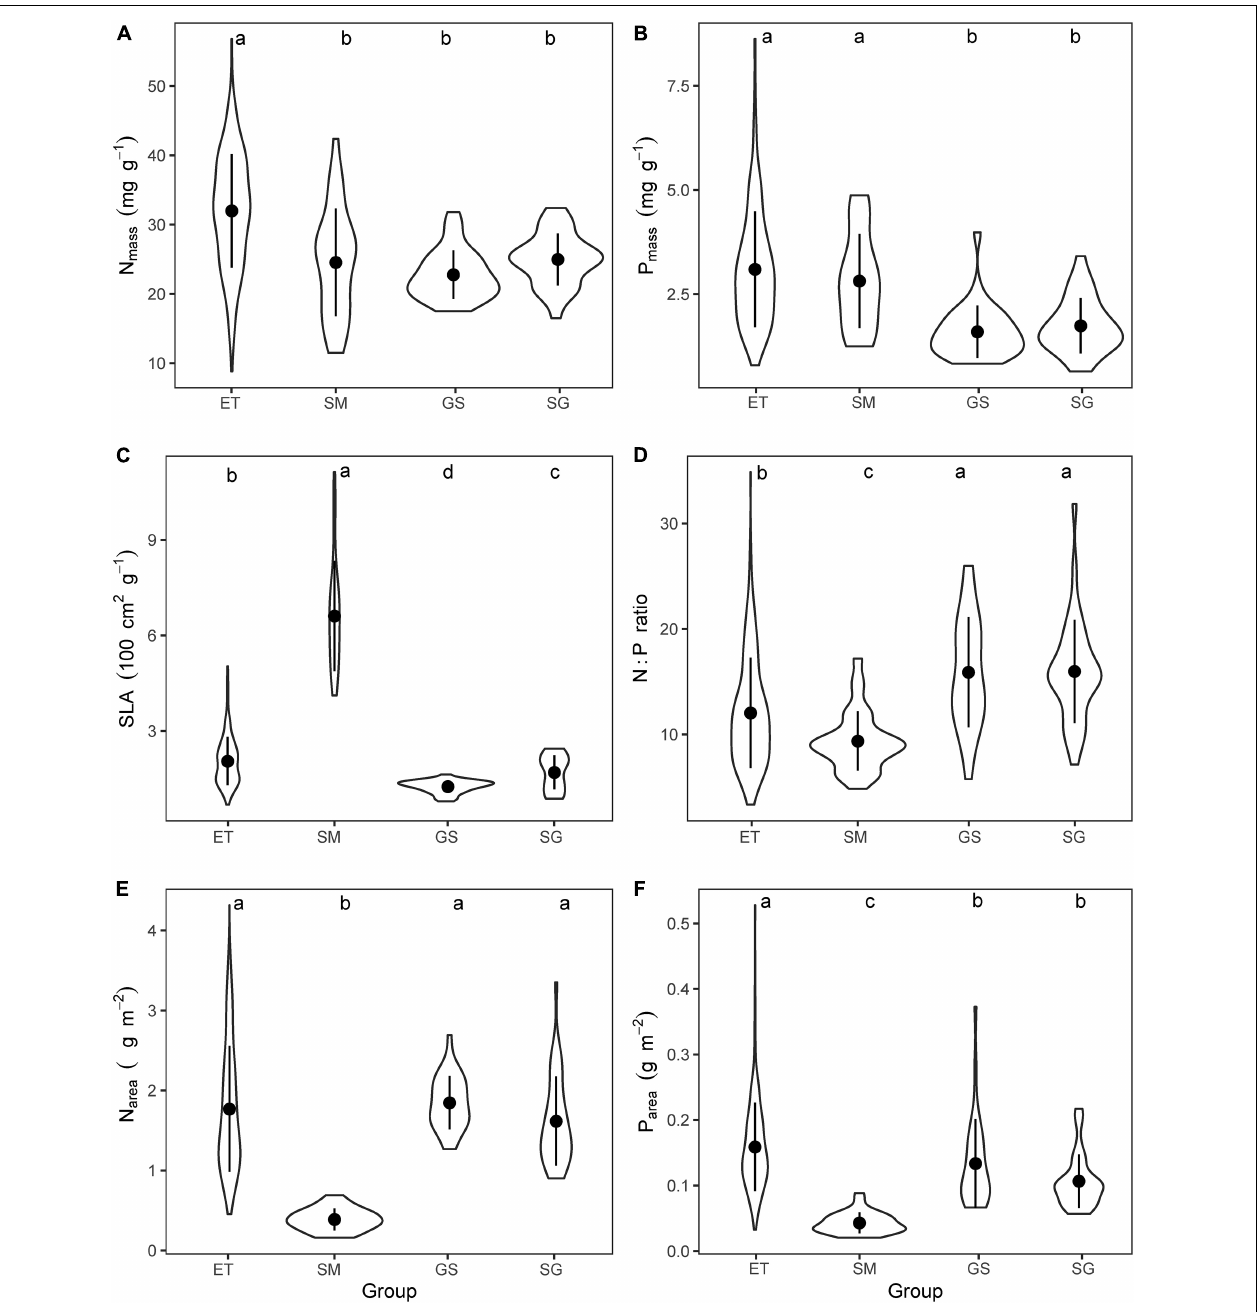
FIGURE 3 | Comparing the mean values of (A) mass-based leaf nitrogen concentration (N mass ), (B) mass-based leaf phosphorus concentration (P mass ), (C) specific leaf area (SLA), (D) mass-based N:P ratios, (E) area-based leaf nitrogen content (N area ), and (F) area-based leaf phosphorus content (P area ) for the four plant groups. ET, emergent plants, GS, grasses, SG, sedges, and SM, submerged plants. The lowercase letters on the top of each panel showed the results of Kruskal–Wallis test and Dunn’s Post Hoc Multiple Comparisons ( p < 0.05).